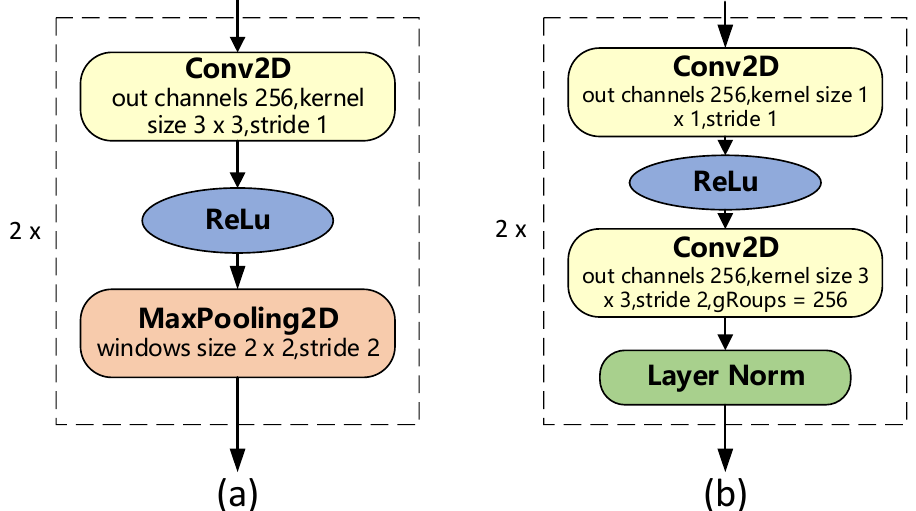
Figure 2. ( a ) The structure of the convolution subsampling layer. ( b ) The structure of the subsam- pling layer replaced with depthwise separable convolution. layer replaced with depthwise separable